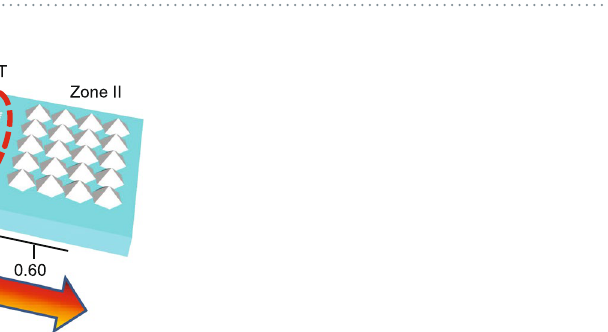
Figure 1. ( a ) Topography of the Al electrodes observed with AFM showing the effect of temperature on roughness, ( b ) Lateral cut profile across the AFM images showing increased roughness and grain sizes with T S < 300 °C, ( c ) SEM images of the Al displaying the increased grain sizes as temperature increases and a mixture of large and small grains at 300 °C and ( d ) Histogram of the grain size distribution of the Al electrode at different sputtering temperatures. All scale bars in ( a , c ) represent 400 nm.